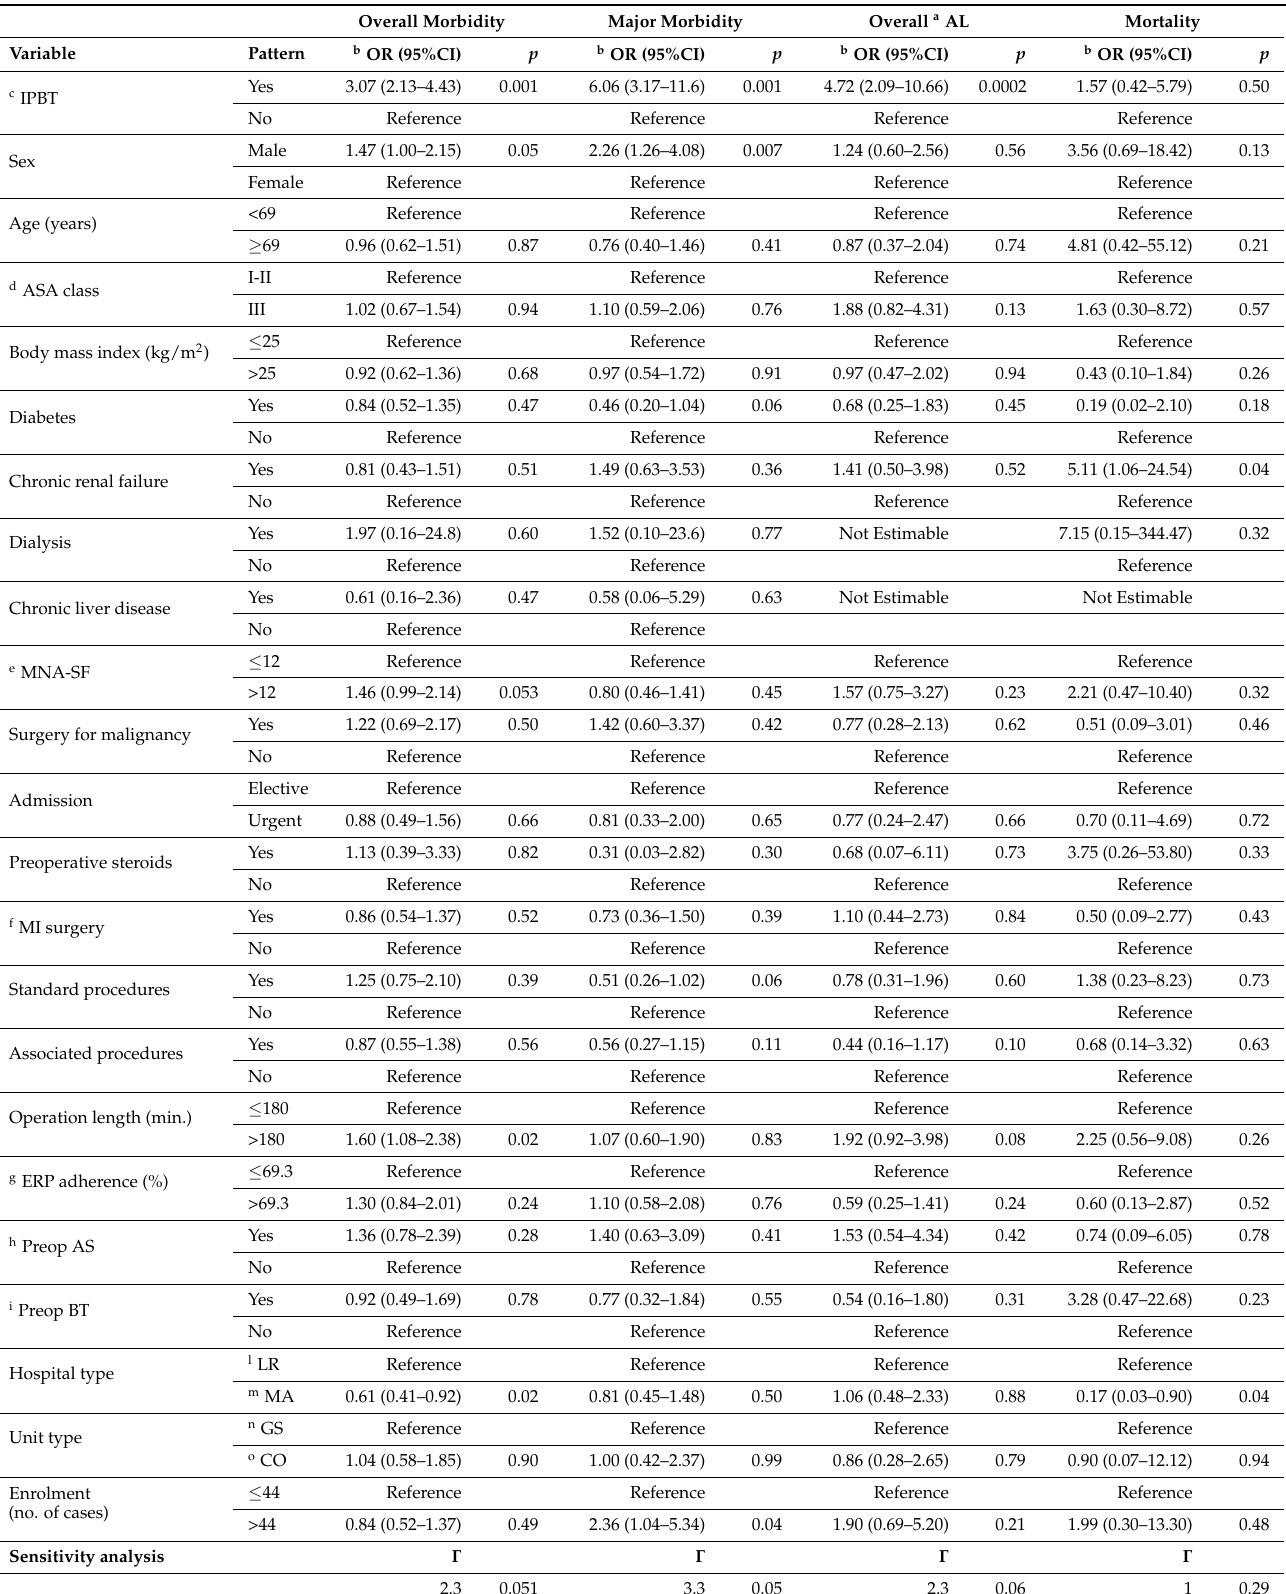
Table 4. Adjusted multiple regression analysis for